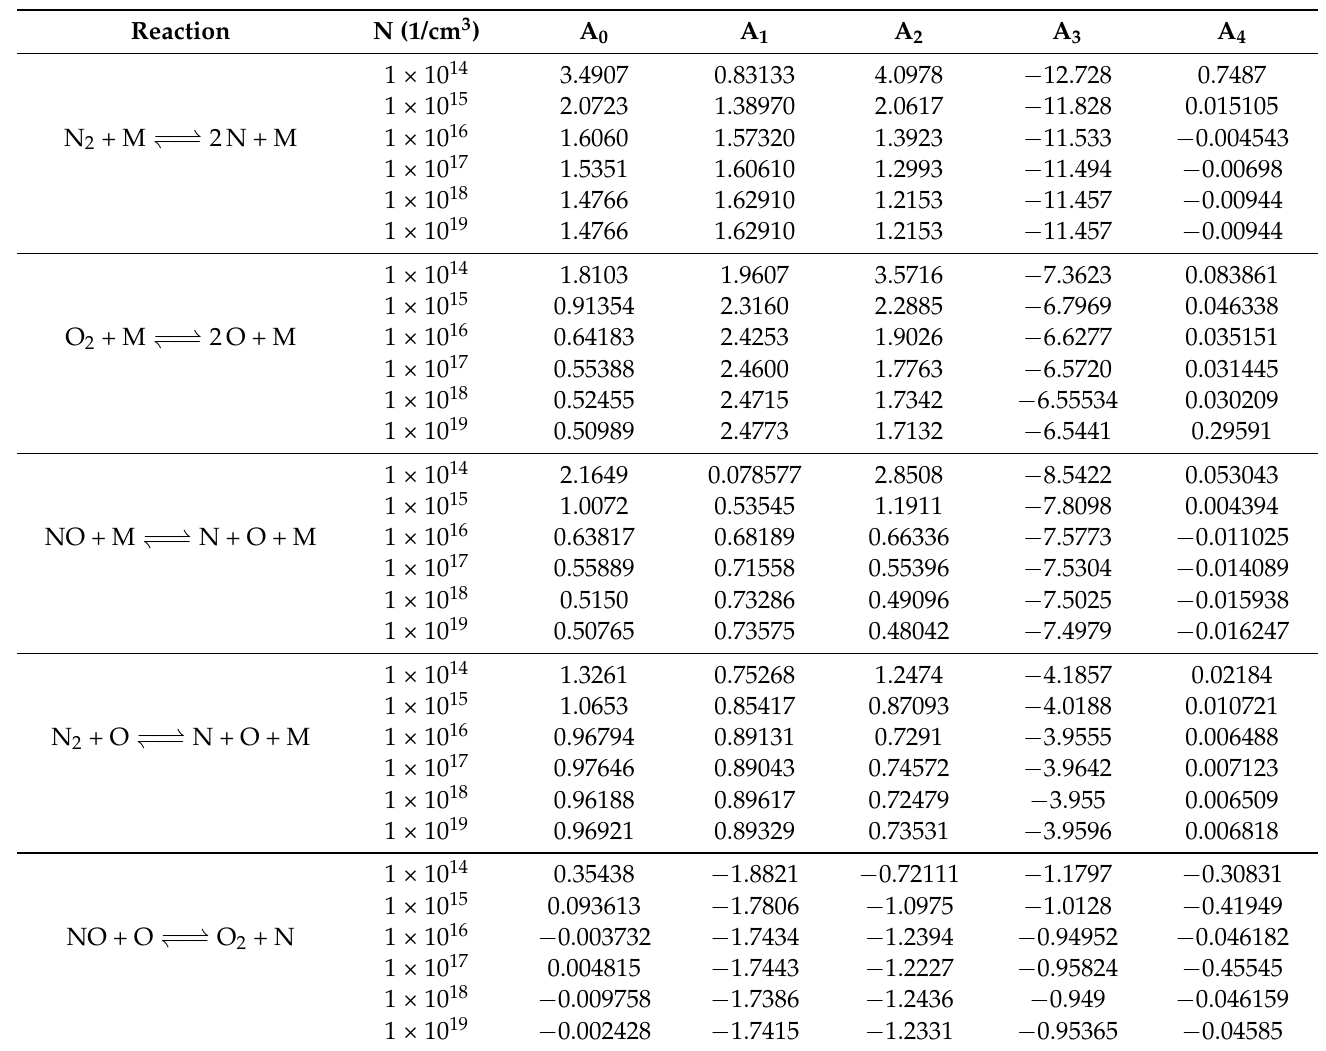
Table A3. Parameters for the Park 1990 equilibrium reaction